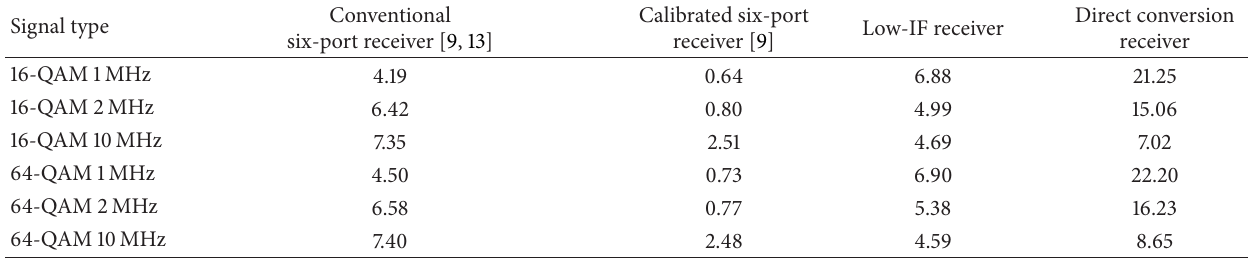
Table 3: EVM (%) performance of different receivers under test.